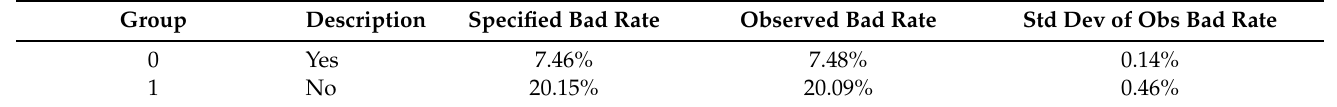
Table 5. Existing customers.